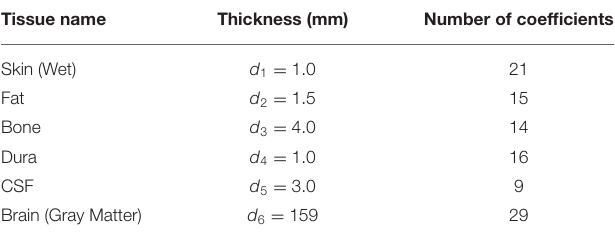
TABLE 3 | Tissue density and thickness of each tissue layer.